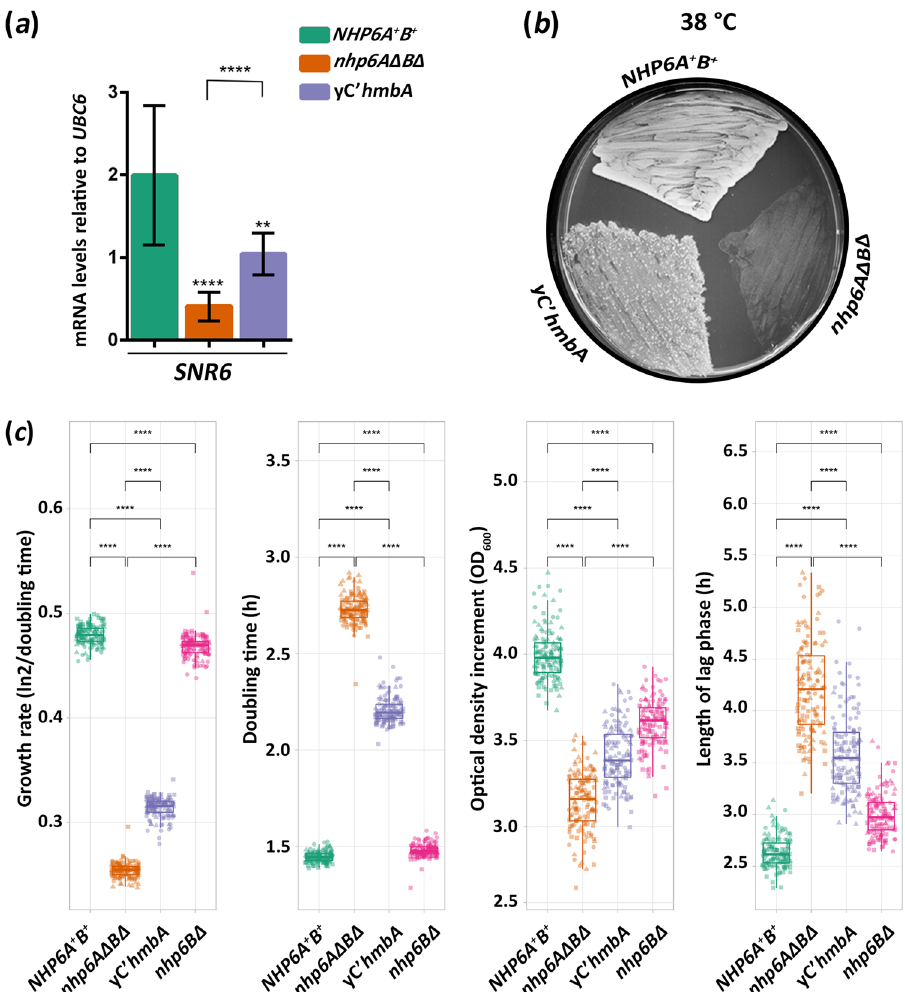
(HZS.891) and yC’ hmbA ( nhp6AΔBΔ complemented with hmbA , HZS.890) strains measured by RT-qPCR. Strains were grown on YPD up to OD 600 = 0.25 at 30 °C followed by 1 h additional incubation at 38 °C.